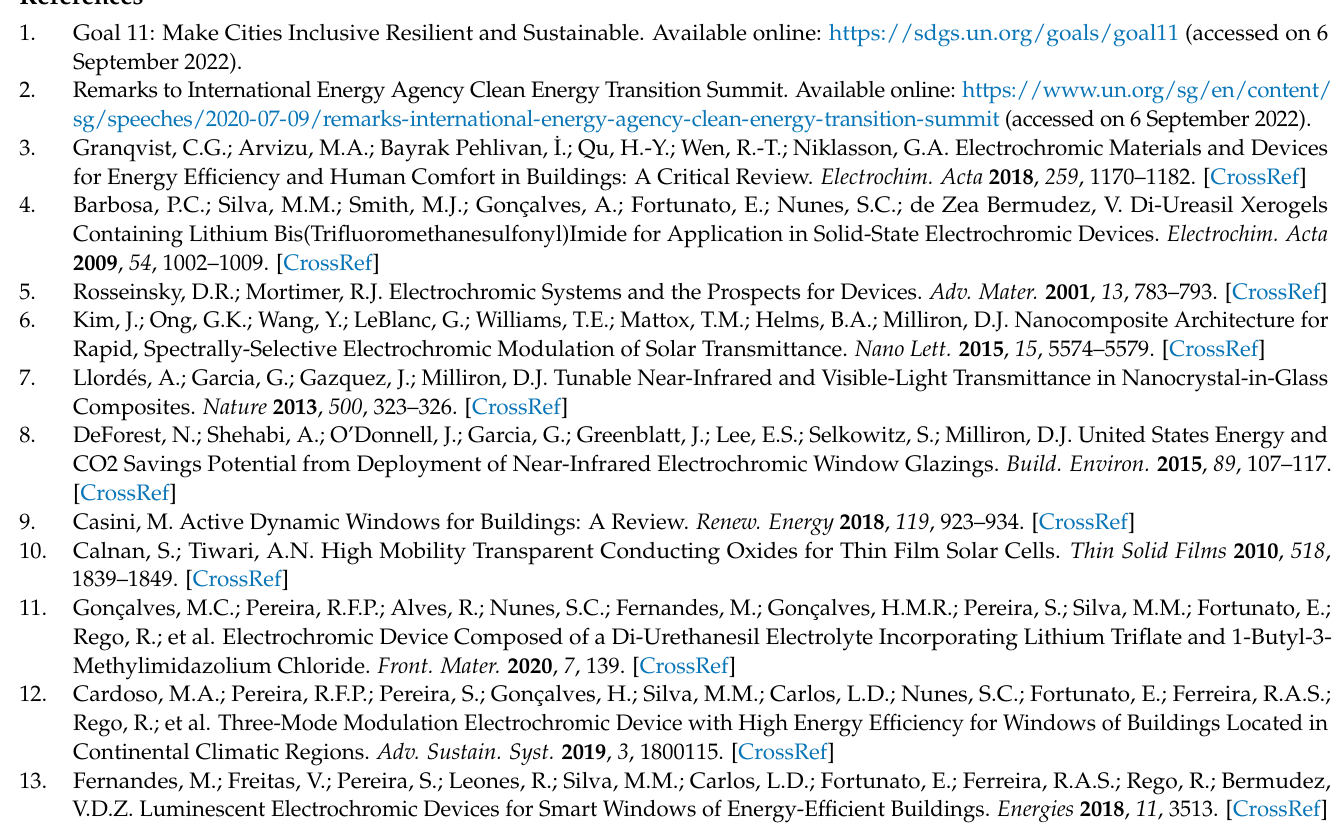
Figure S3: Time intervals (s) at which the CE values were measured and calculated. Figure S4: Inserted (-Q in ) (a) and de-inserted (Q out ) (b) charge